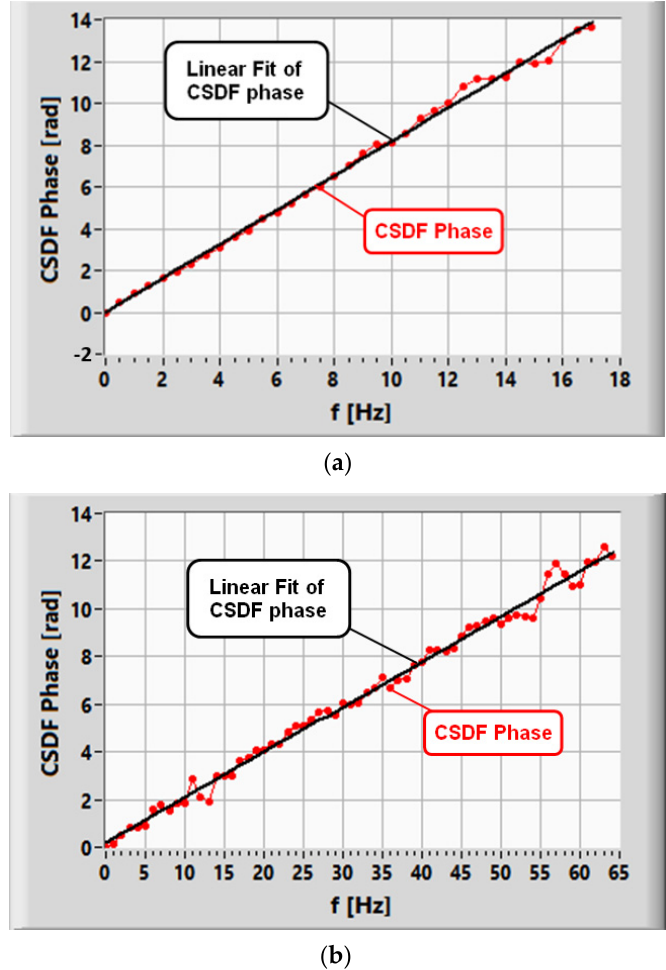
Figure 6. The phase of the CSDF in the experiments ( a ) BUB10 and ( b ) WRQ30. The behaviour of the estimator of the coherence function γ xy ( f ), which is the nor- malised CSDF [37], can be used to select the appropriate frequency range for the linearisa- tion of the characteristic (cid:101) Φ xy ( f k ) . In practice, the square of this function module is used, which for all of the frequencies take values that are from 0 to 1: